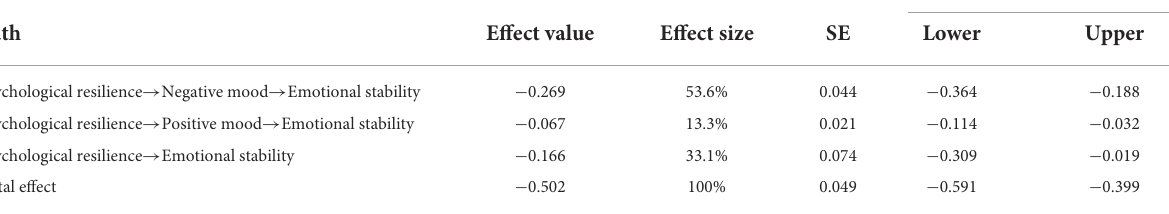
TABLE 3 Mediating effects of positive and negative mood states on the relationship between psychological resilience and emotional stability.